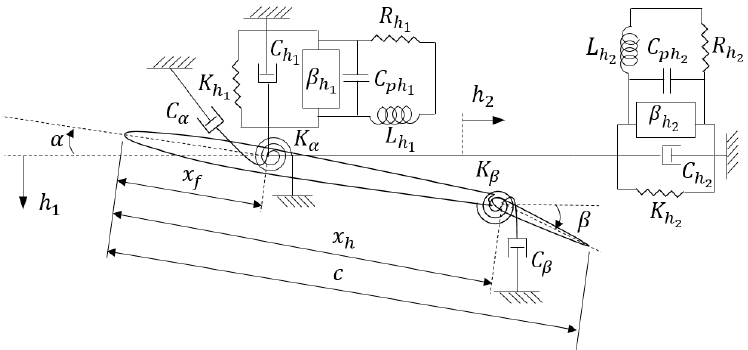
Figure 8. The smart blade system responses of the rotational displacement with 𝑃 = 0 .